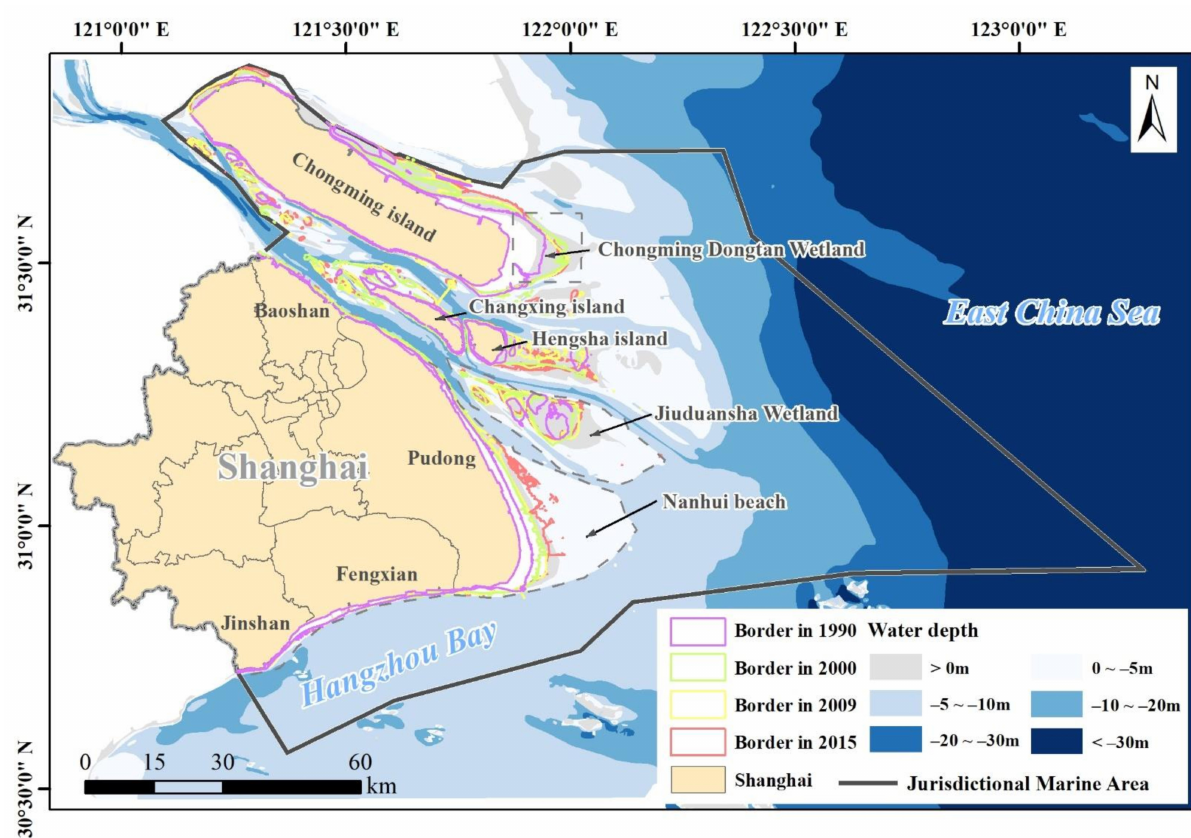
Figure 1. The location and scope of the study